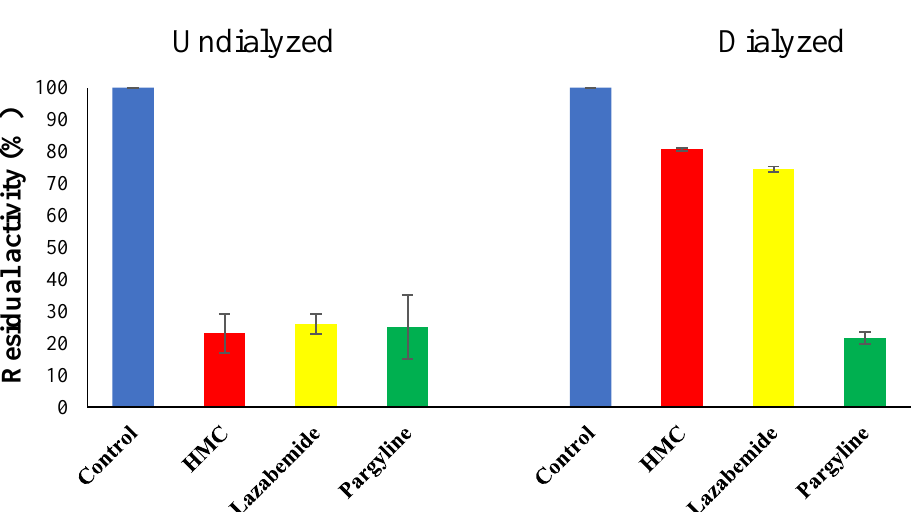
Figure 5. Inhibition of HMC of MAO-B and recovery activity by dialysis. Concentrations of ~2× IC 50 were used.